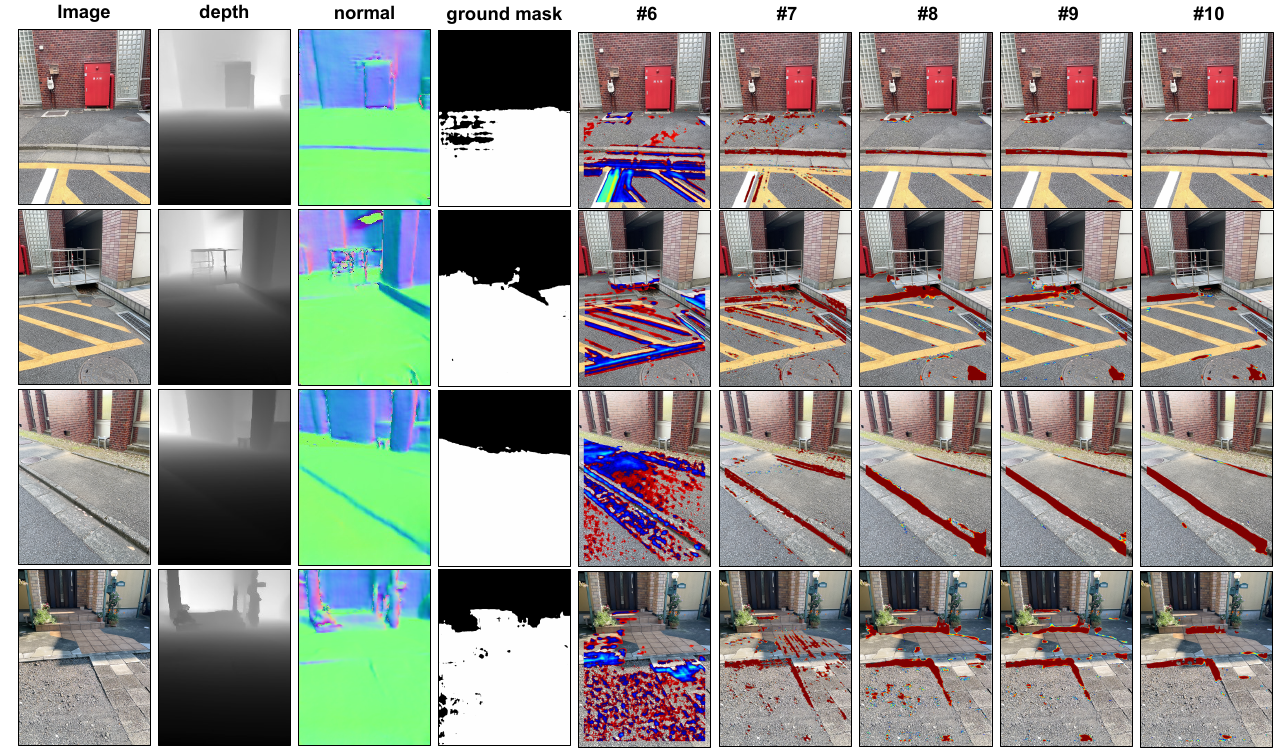
Figure 12. Results with a patch size of 64 × 64 as input. The numbers correspond to the numbers in Table